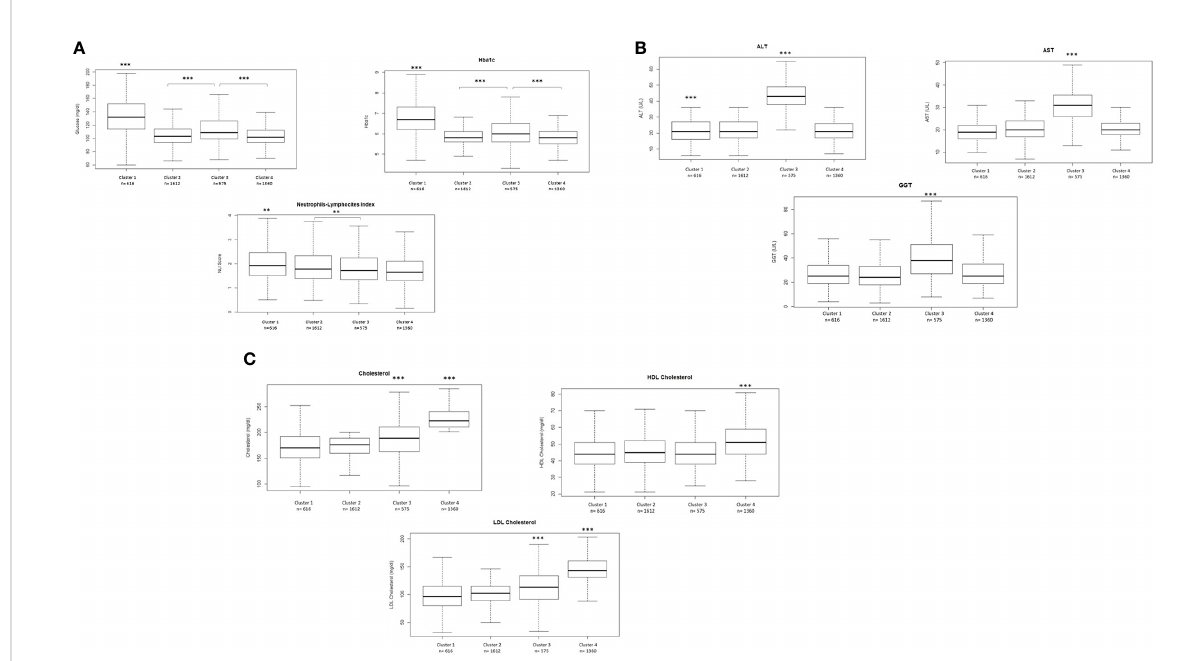
FIGURE 4 (A) Differences in glucose. Hba1c and NLI between clusters. (B) Differences in transaminases levels between clusters. (C) Differences in total cholesterol. HDL-cholesterol and LDL- cholesterol levels between clusters. Comparisons were carried out using a Student's t-test adjusted by